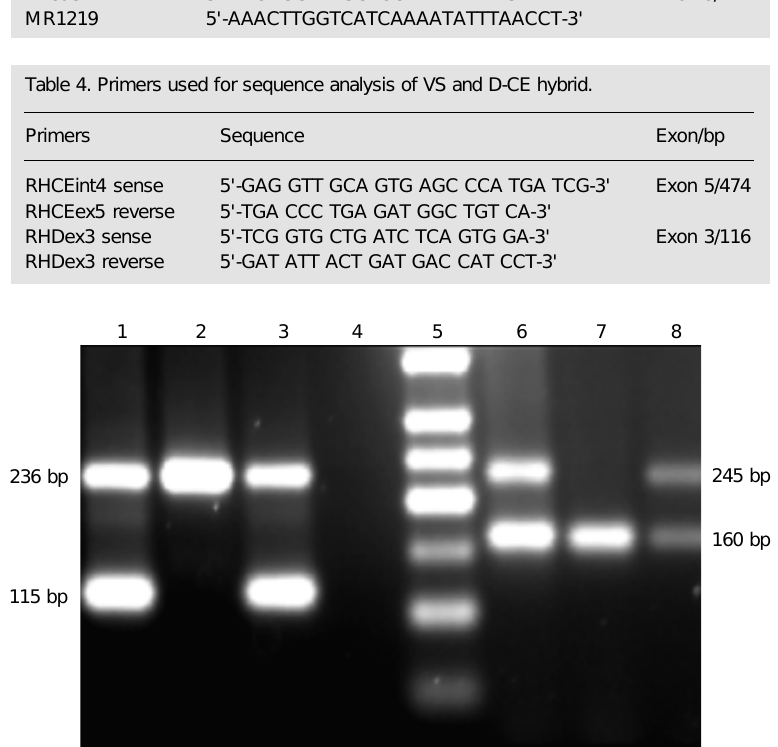
Figure 1. RHD genotyping by intron 4 and exon 10 of RHD . Lanes 1 and 3 : RHD -positive samples display bands of 236 bp for RHCE and 115 bp for the RHD intron 4 sequence. Lane 2 : RHD- negative sample displays only the 236-bp band corresponding to the RHCE intron 4 sequence. Lane 4 : Reaction blank. Lane 5 : 50-bp DNA ladder. Lanes 6 and 8 : RHD- positive samples that amplify a 245-bp product of the RHD and a 160-bp product of the RHCE exon 10 sequence. Lane 7 : RHD- negative sample displays only the 160-bp band corresponding to the RHCE exon 10 sequence.